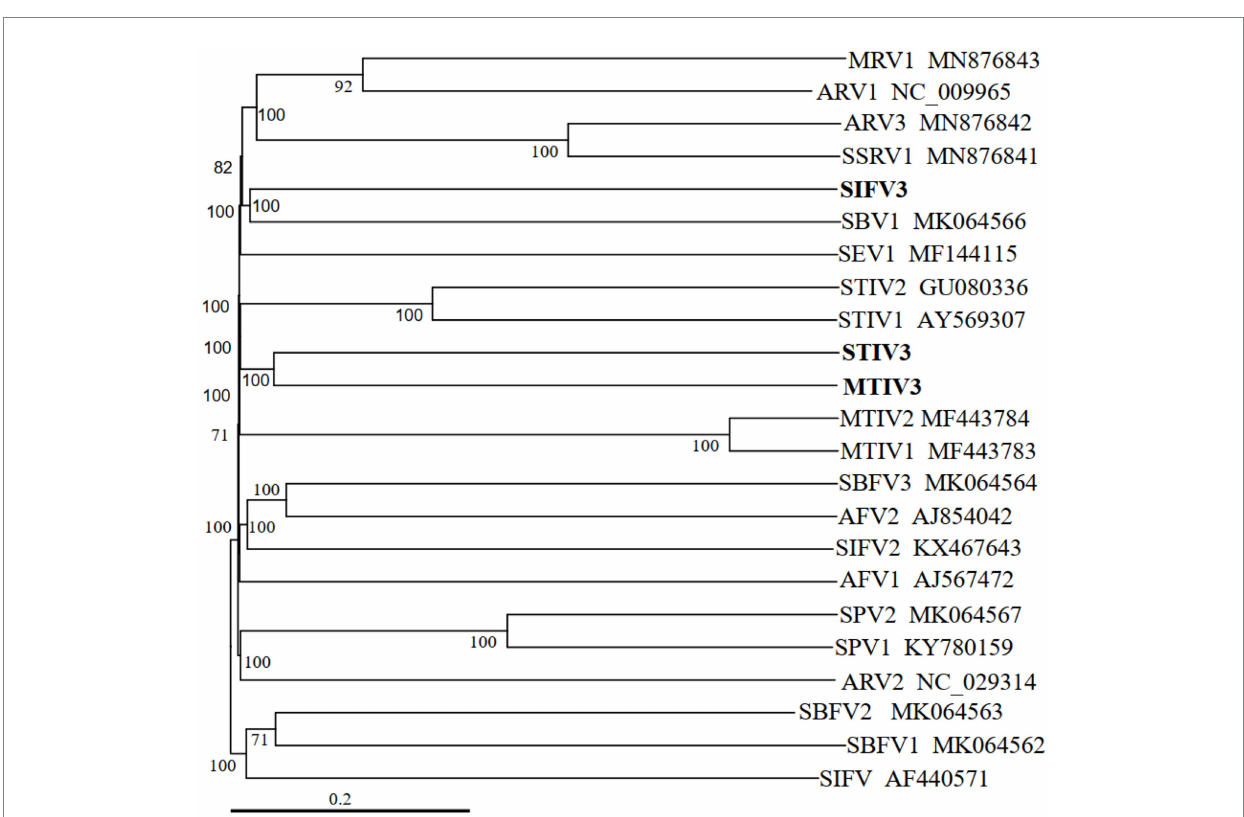
FIGURE 4 Phylogenetic tree of archaeal viruses based on whole genome analysis at the amino acid level using VICTOR (Meier-Kolthoff and Göker, 2017). The tree is rooted at mid-point, and the branch length is scaled in terms of the distance formula D6. The branch supporting value >50% is shown. For each genome, the virus name and the GenBank accession number are indicated. The newly isolated viruses from this study are marked in bold